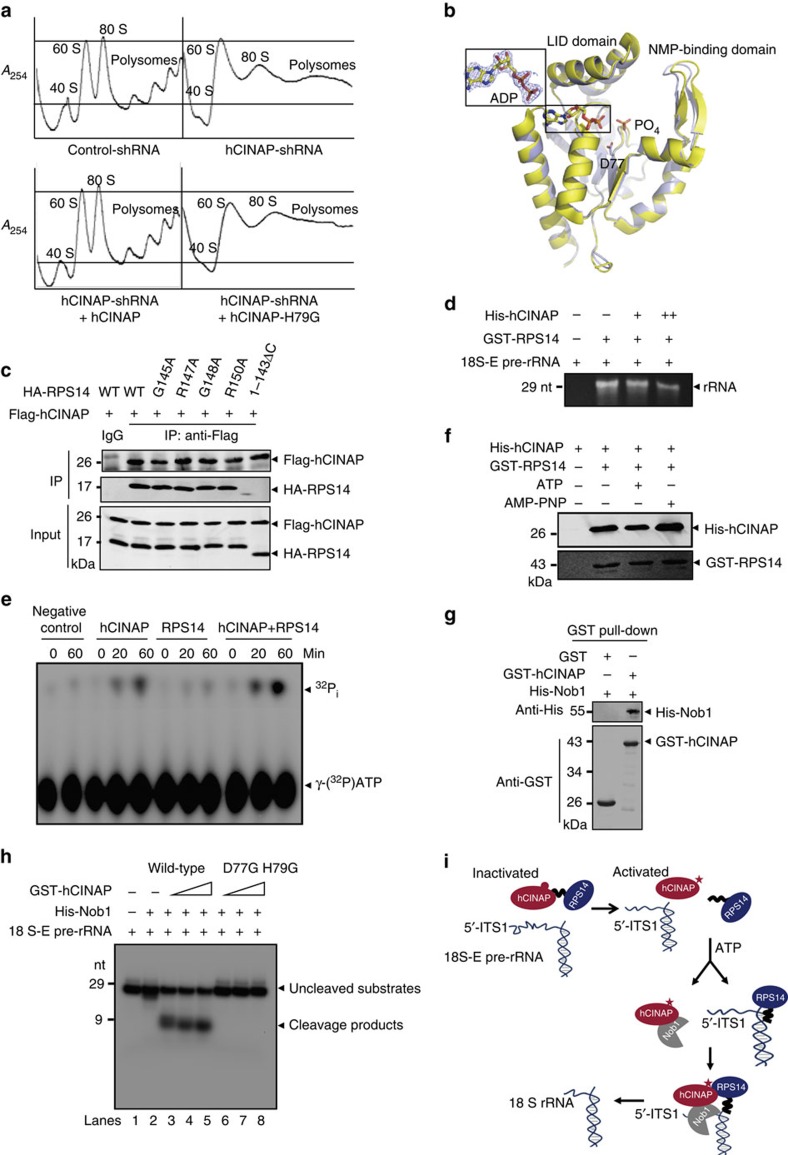
The ATPase activity of hCINAP is orchestrated by RPS14 and essential for Nob1-mediated 18S rRNA processing.(a) hCINAP-depleted cells were transfected with wild-type or ATPase-defective hCINAP, after which 40S subunit formation was detected by sucrose density gradient centrifugation. (b) Structural superposition of hCINAP-D77G (yellow) with hCINAP-ADP (light blue, PDB code: 5JZV). The 2Fo–Fc map of ADP in the structure of hCINAP-D77G-ADP is contoured at 1.4 ó (shown in the box). The side chain of D77 and a phosphate group in hCINAP-ADP are also shown. (c) 293T cells were transfected with Flag-hCINAP and the mutants or truncation of HA-RPS14. Cells were harvested and the interaction between hCINAP with RPS14 was examined with indicated antibodies. (d) Pull-down assay was carried out to detect the effect of hCINAP on the binding capacity of RPS14 with 18S-E pre-rRNA. (e) Thin-layer chromatography analysis was performed with γ-[32P]ATP to examine the effect of RPS14 on the ATPase activity of hCINAP. Radioactively labelled products were visualized using a phosphor screen. (f) In vitro pull-down assay was performed to detect the interaction between hCINAP with RPS14 in the presence of ATP or non-hydrolysable ATP homologue AMP-PNP. (g) Determination of hCINAP and Nob1 interaction by GST pull-down experiments. (h) In vitro RNA cleavage assay to detect 18S-E pre-rRNA cleavage by Nob1 with wild-type hCINAP or the enzymatic mutants of hCINAP. (i) A model of regulation of 18S rRNA processing by hCINAP. In the pre-40S particles, hCINAP binds to the C-terminal of RPS14 and blocks binding of RPS14 to premature 18S rRNA, which may lead to a conformational change in the pre-rRNA. Meanwhile, RPS14 stimulates the ATPase activity of hCINAP, whereas ATP hydrolysis by hCINAP dissociates the hCINAP–RPS14 complex, which may facilitate proper assembly of RPS14 with rearranged pre-rRNA. Subsequently, hCINAP interacts with Nob1 and activates Nob1-mediated 18S rRNA processing.